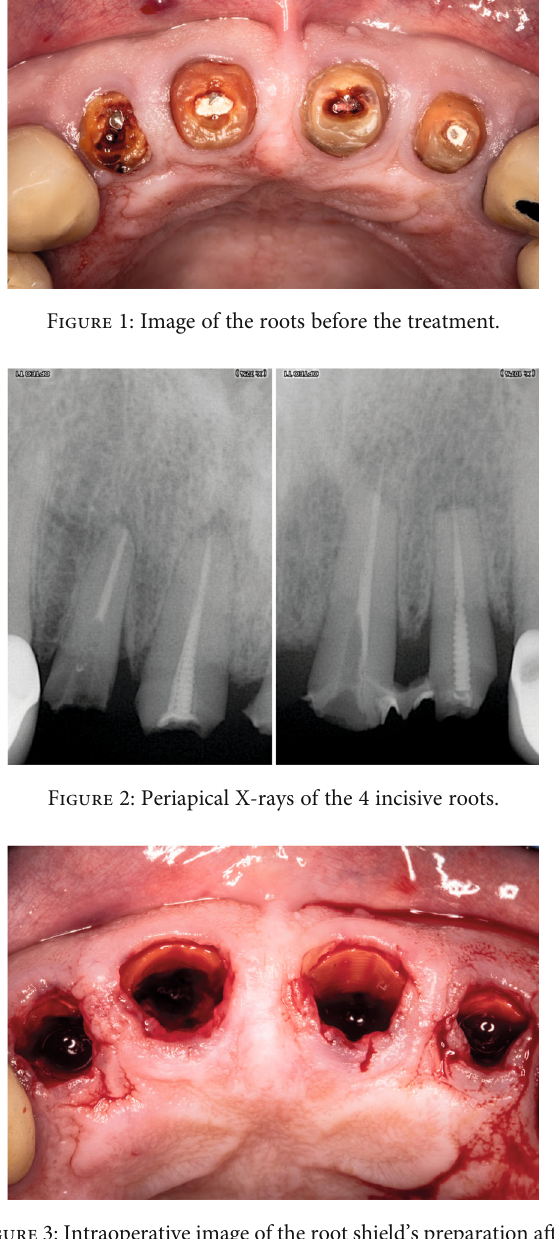
Figure 3: Intraoperative image of the root shield ’ s preparation after extraction.